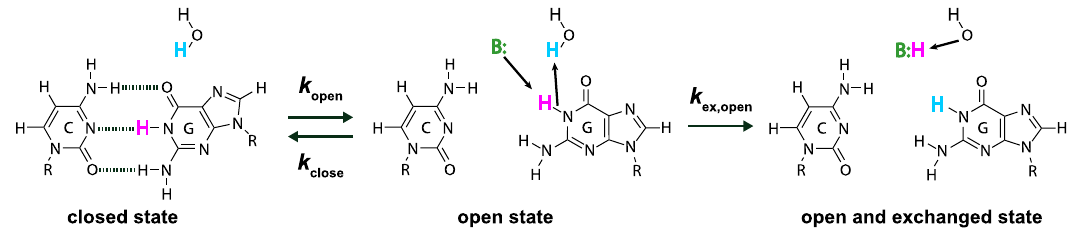
Fig. 1 | Imino proton exchange reaction. There are “ closed ” , “ open ” , and “ open and exchanged ” states. The rate constants for base-pair opening, k open , base-pair